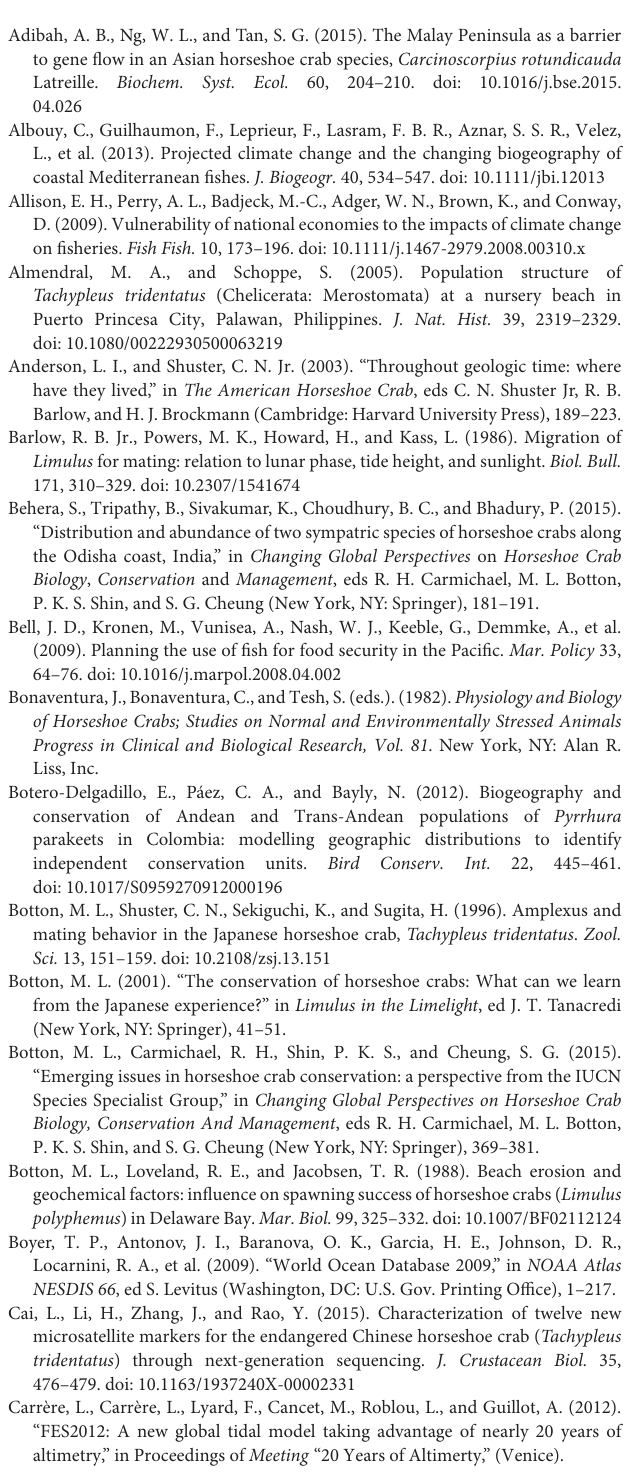
Supplementary Table 6 | Loadings for the different environmental variables shown for all PCA components for C. rotundicauda .